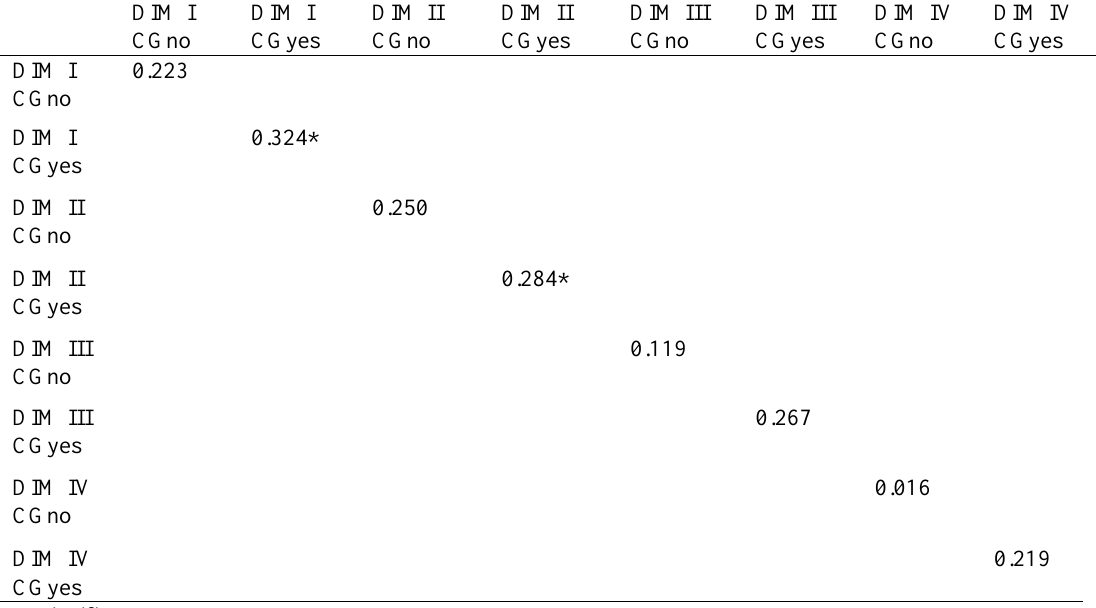
Table 3.Spearman correlation values for positive and negative questions for the CGno and